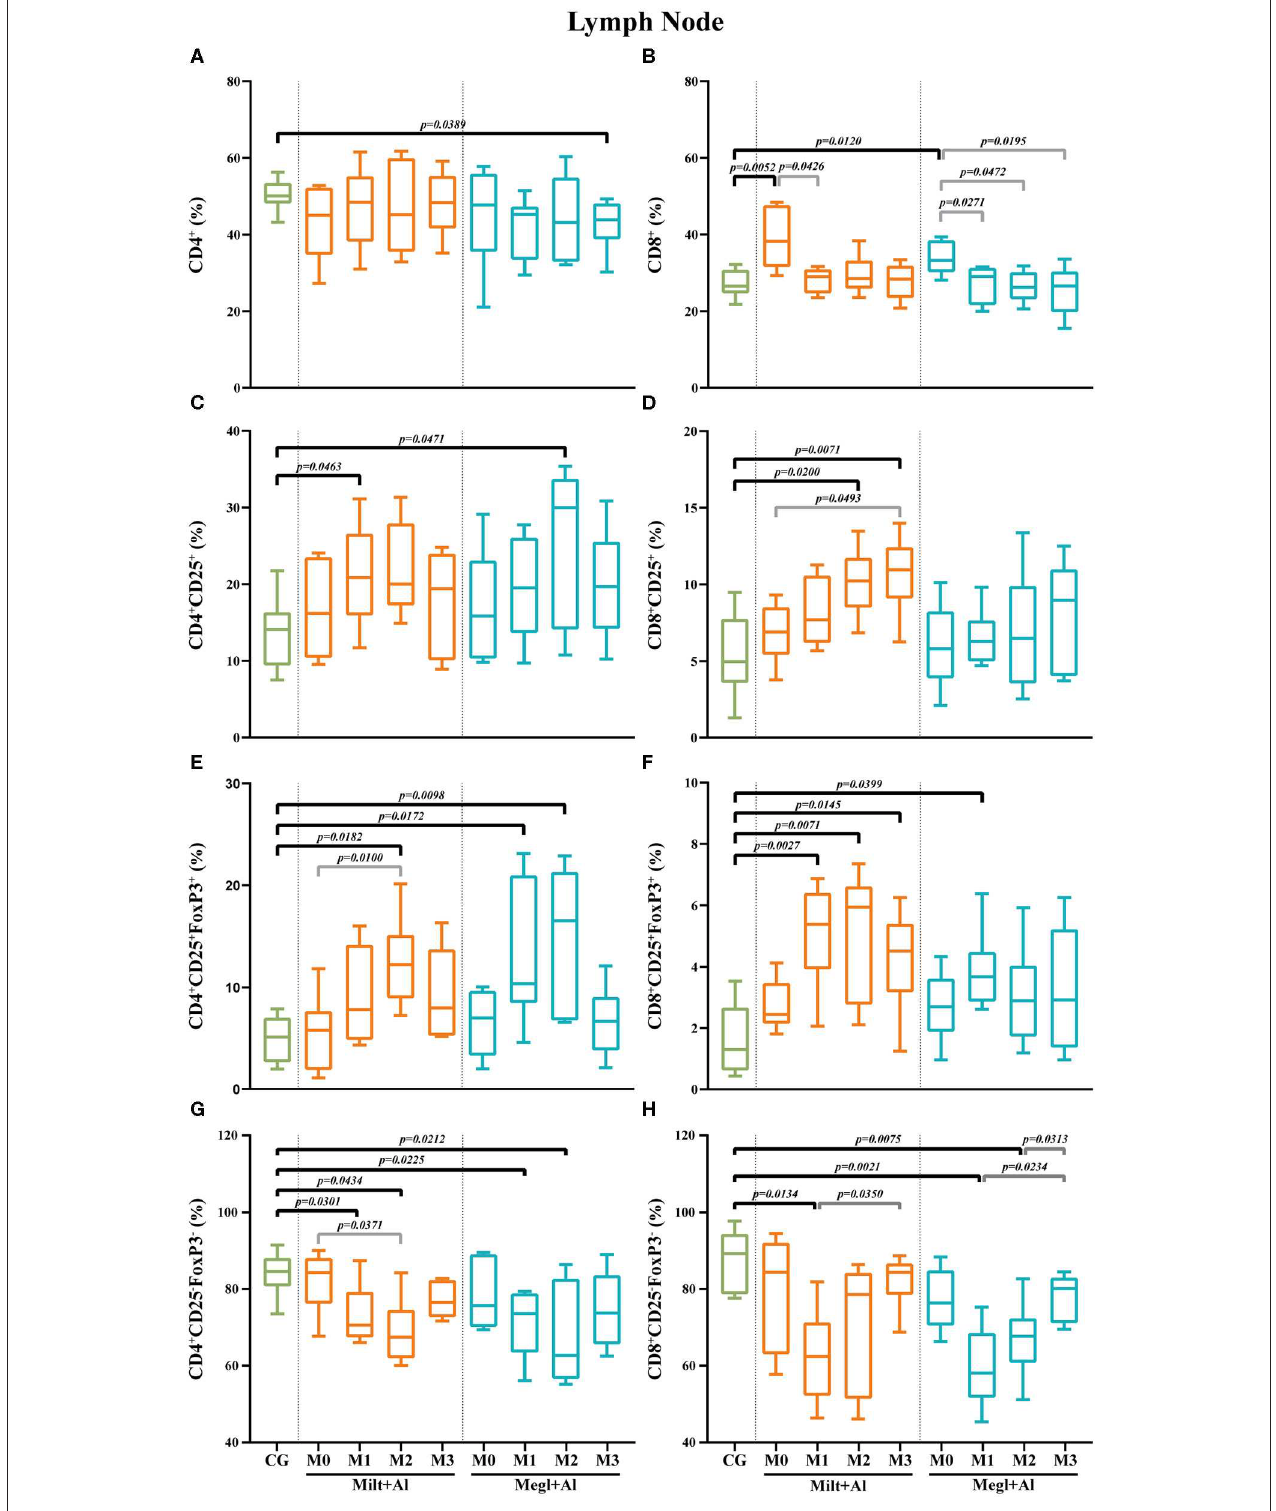
FIGURE 8 | Frequency of CD4 + (A) , CD8 + (B) , regulatory (CD25 + FoxP3 + ) (C–F) , and effector (CD4 + CD25 − FoxP3 − /CD8 + CD25 − FoxP3 − ) (G,H) T lymphocytes in the lymph node of healthy [control group (CG)], sick (M0), and treated dogs (M1, M2, and M3). Results of 22 dogs are represented by box and whisker plots and median, minimum, and maximum values. The non-parametric Kruskal–Wallis test (one-way ANOVA on ranks) with Dunn’s post hoc test was used for statistical comparisons between treatment groups and the CG. The repeated measures ANOVA test with Tukey’s post hoc test was used for statistical comparisons inside each treatment group. p -values are indicated in every statistically significant